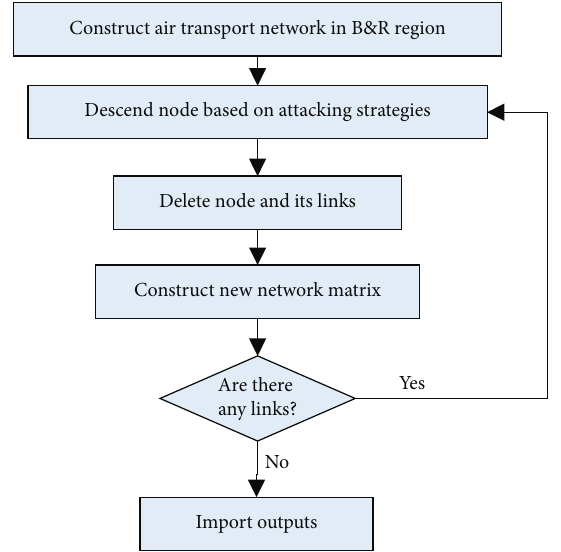
Figure 2: Flowchart of attacking